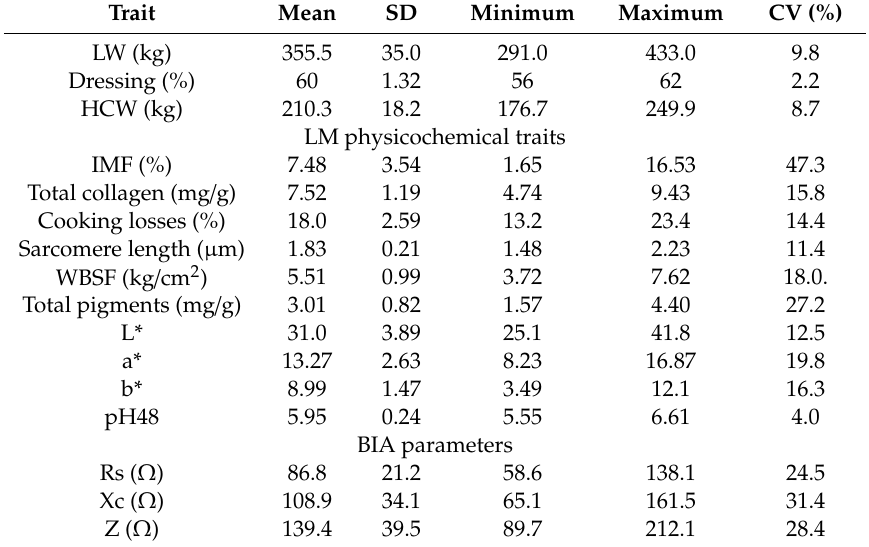
Table 1. Descriptive statistics for live weight (LW), dressing, hot carcass weight (HCW), longissimus thoracis et lumborum muscle (LM) physicochemical traits, and bioelectrical impedance (BIA) parameters (n =